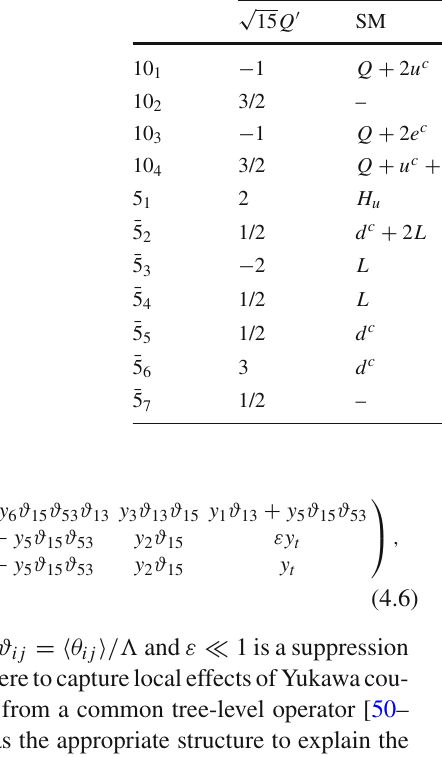
Table 8 MSSM like models accompanied by a general singlet spectrum